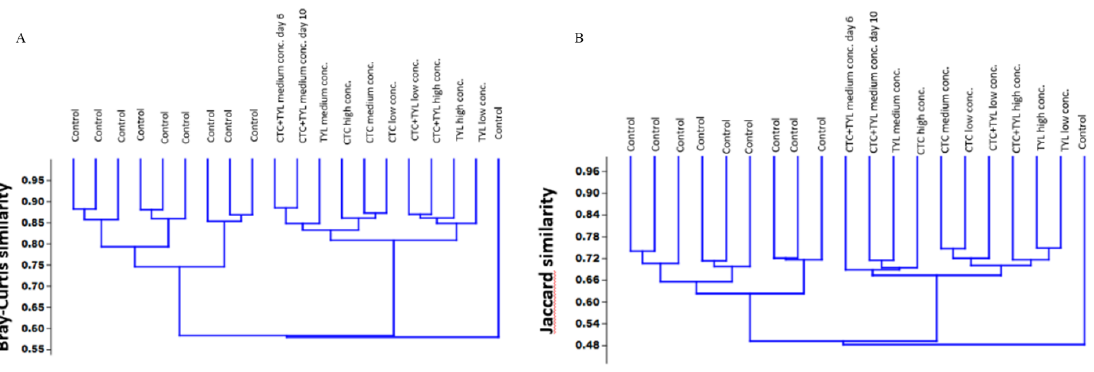
Figure 11. Dendrogram of bacterial community based on ( A ) Bray–Curtis similarities and ( B ) Jaccard similarities.